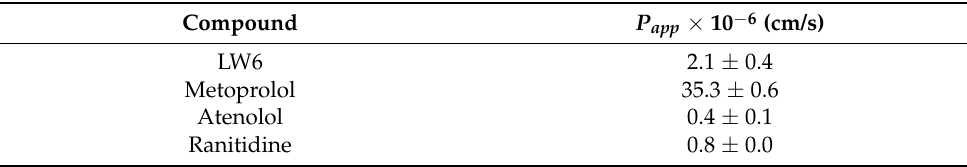
Table 3. Permeability of LW6 in Caco-2 monolayer.